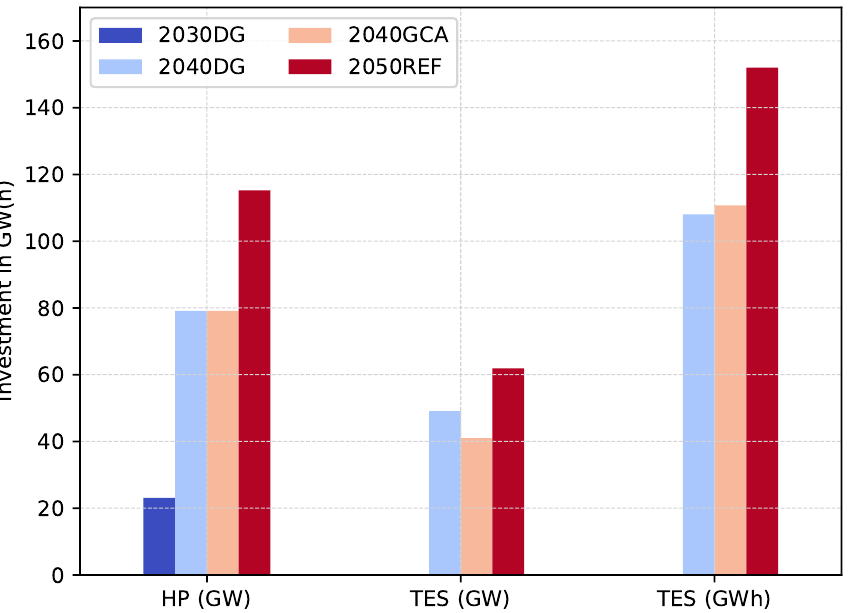
Figure 3. Investment in decentral heating system components for different scenarios. Units are given in GW and